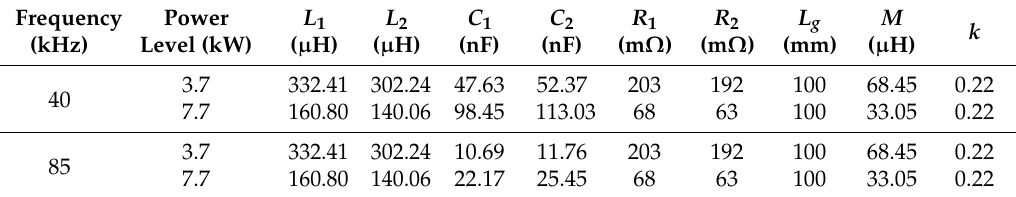
Table 2. Parameters of SS compensation topology for the 3.7 kW and 7.7 kW WPT systems.